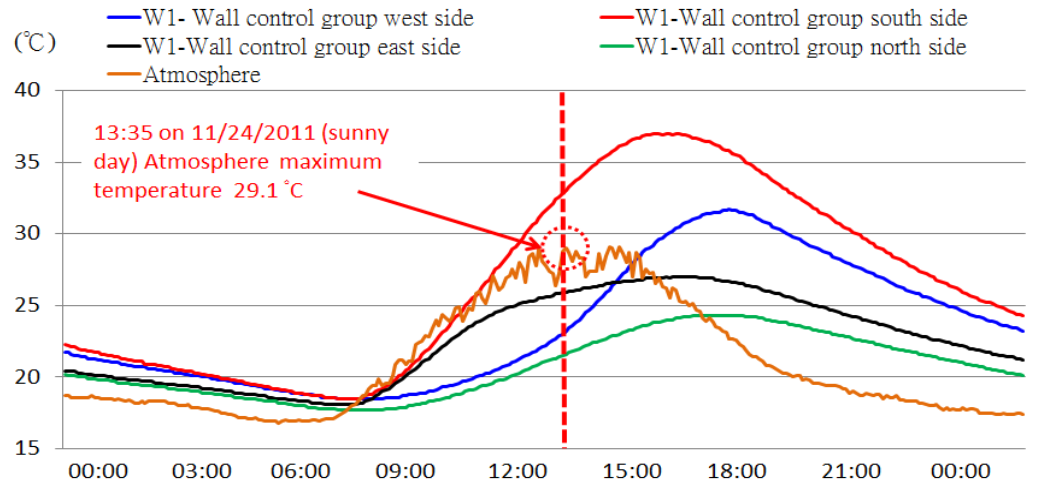
Figure 11. The effect of sunshine and direction on heat storage of outer walls.